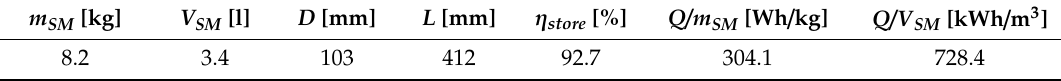
Table 5. Storage medium (SM)—central results for the selected solution at maximum temperature of 1000 °C.